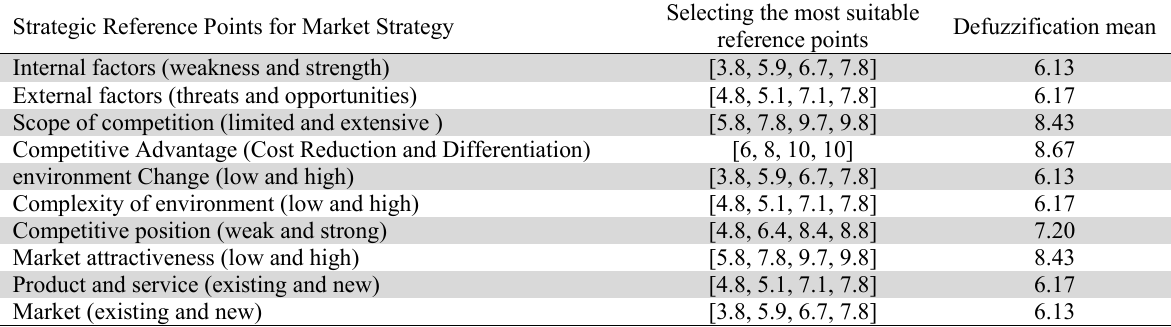
Selecting the most suitable